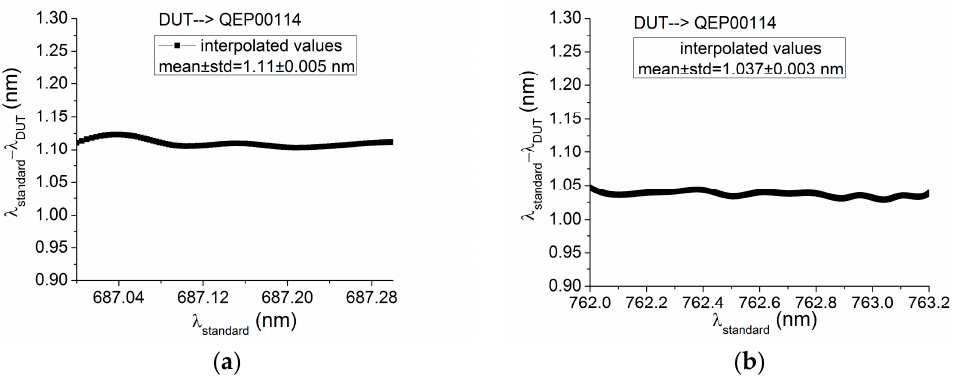
Figure 13. The fluorescence spectrometer wavelength correction within the spectral ranges ( a ) 680 nm to 687.3 and ( b ) 762 nm to 763.2 nm, using the high-resolution configuration of OL750D.